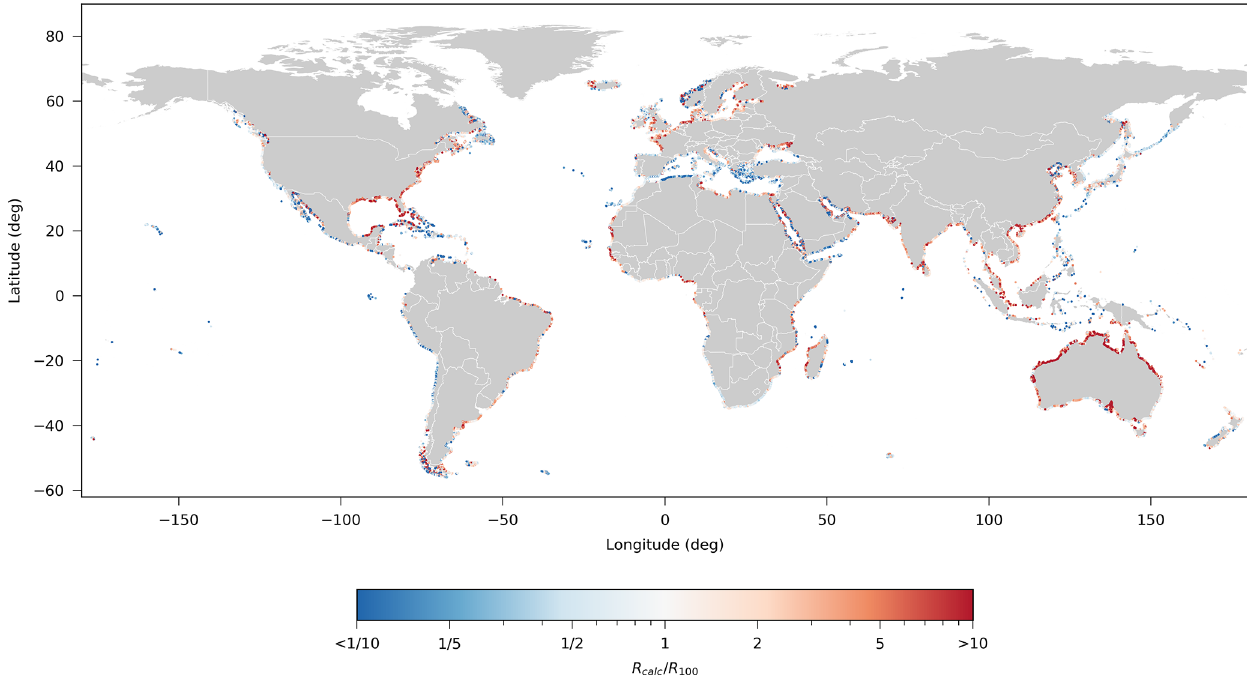
where red colors indicate locations where the tan( β sf ) = 1 : 100 assumption underestimates the coastal Figure 10. Global map of R calc R 100 recession while blue colors indicate locations where it overestimates it. Note that the color bar uses a log scale.